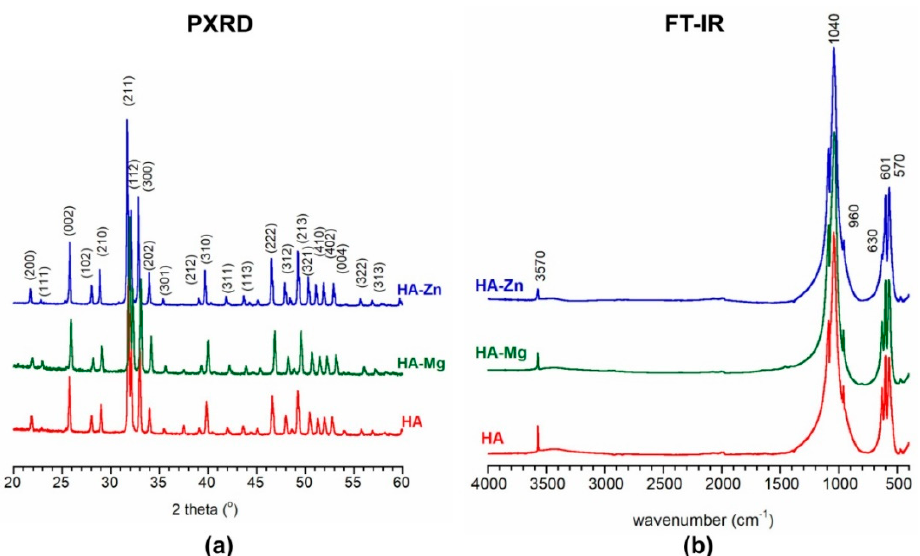
Figure 2. Powder X-ray diffraction (PXRD) patterns ( a ) and Fourier-transform infrared spectroscopy (FT-IR) spectra ( b ) of the synthesized calcium phosphate ceramics (nanoHA) powders. Table 1. Parameters obtained from the PXRD patterns: unit cell parameters a and c (nm) and average crystallite sizes determined from (002) reflection.